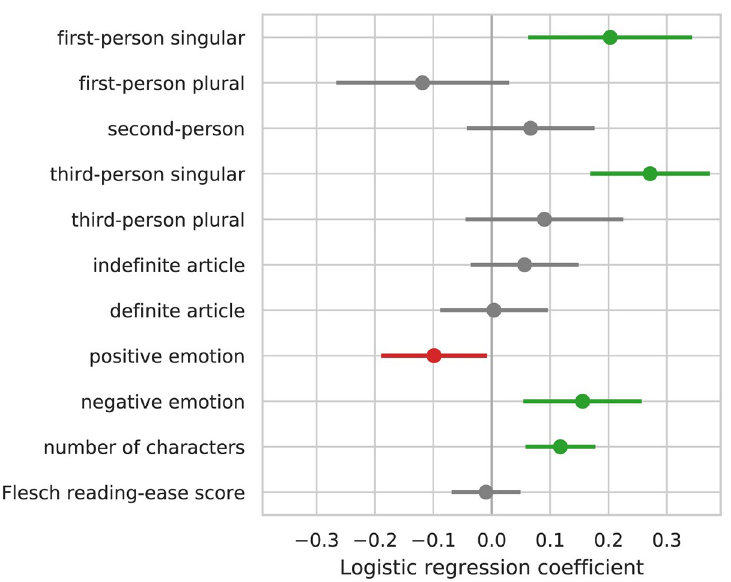
Fig 2. Main regression analysis on the Upworthy Archive Exploratory Dataset. Error bars show 95% confidence intervals on the logistic regression coefficients.